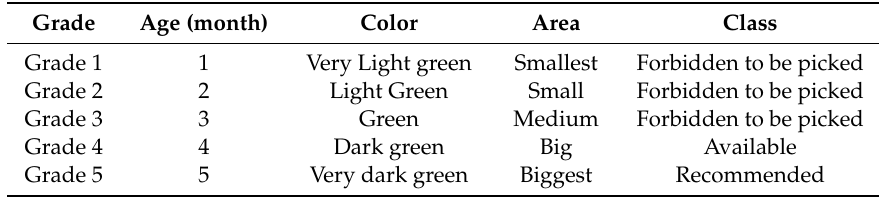
Table 1. Criteria of leaf groups.